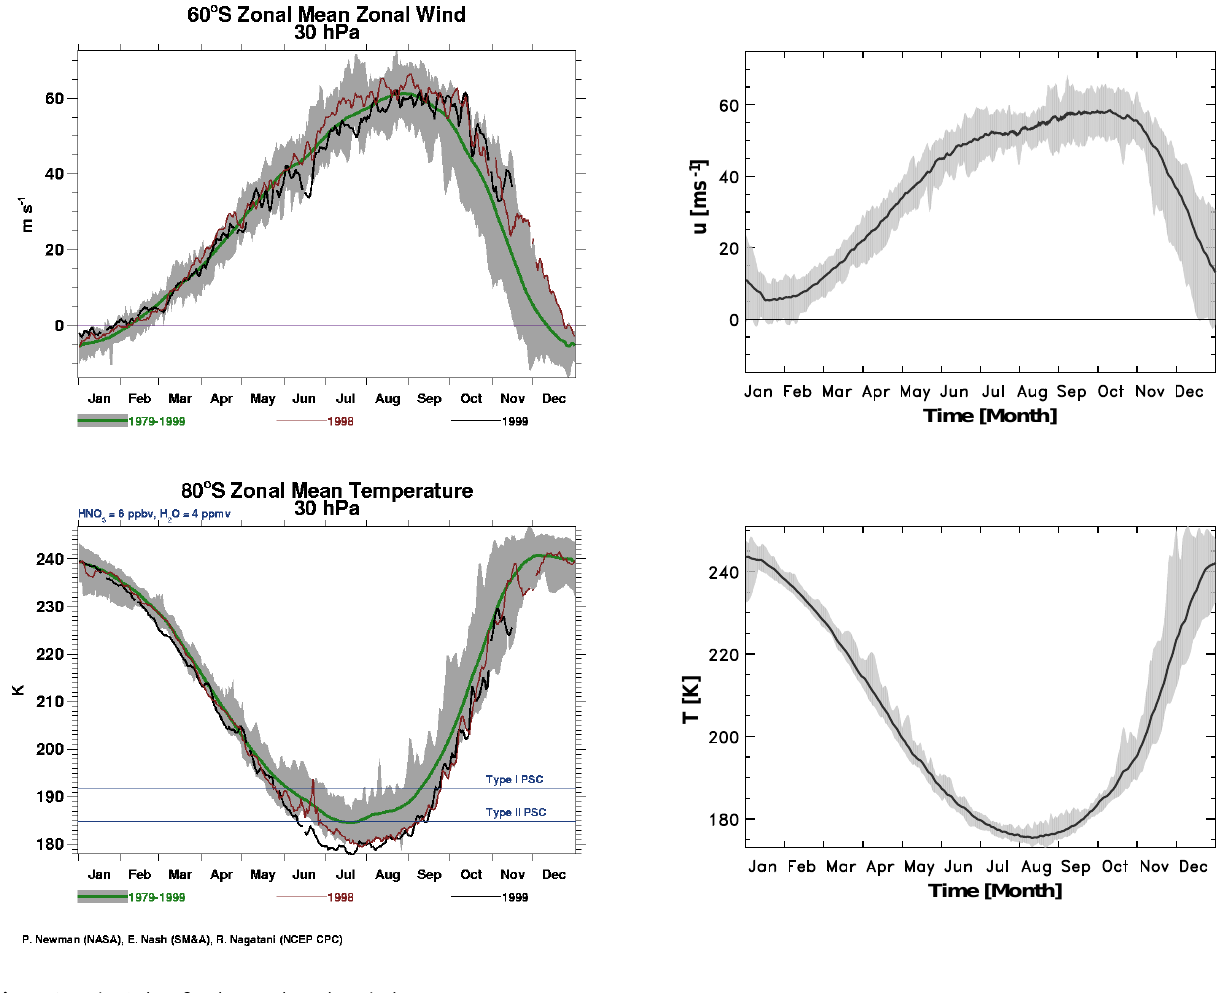
Fig. 4. As Fig. 3, but for the southern hemisphere.